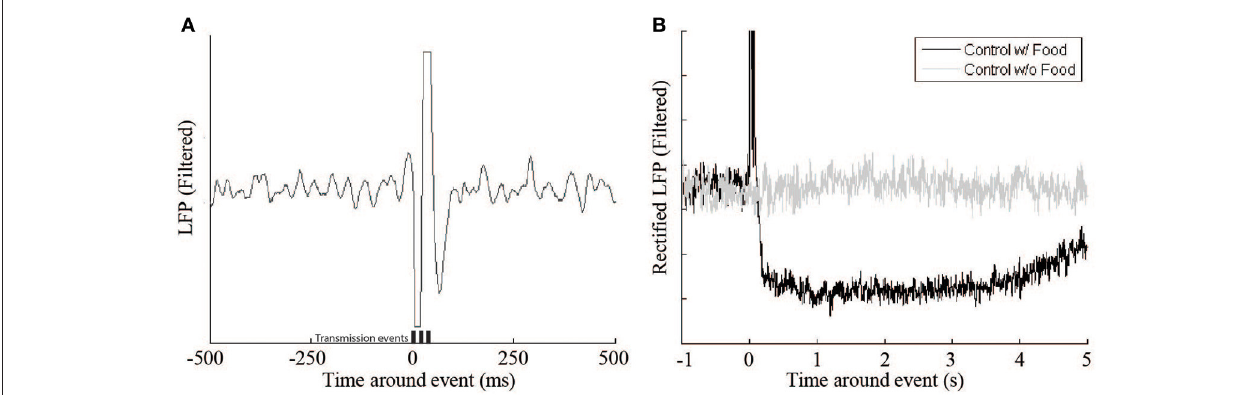
FIGURE 5 | Beta LFP signal response during control experiments. (A) This figure shows a single Radio Frequency transmitter artifact during a control experiment where no food reward or feedback was delivered. Transmission events are represented by the bars ( t = 0, 20, 40 ms). (B) The receipt of a food pellet (black trace) causes a drop in overall beta power compared to a non-food event (gray trace).